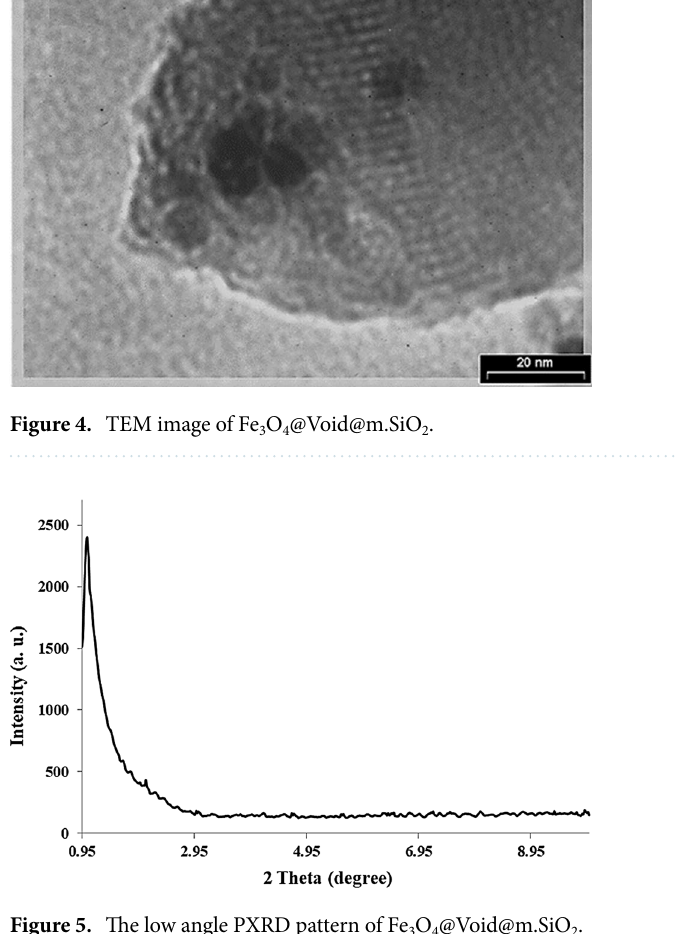
Figure 5. The low angle PXRD pattern of Fe 3 O 4 @Void@m.SiO 2 .